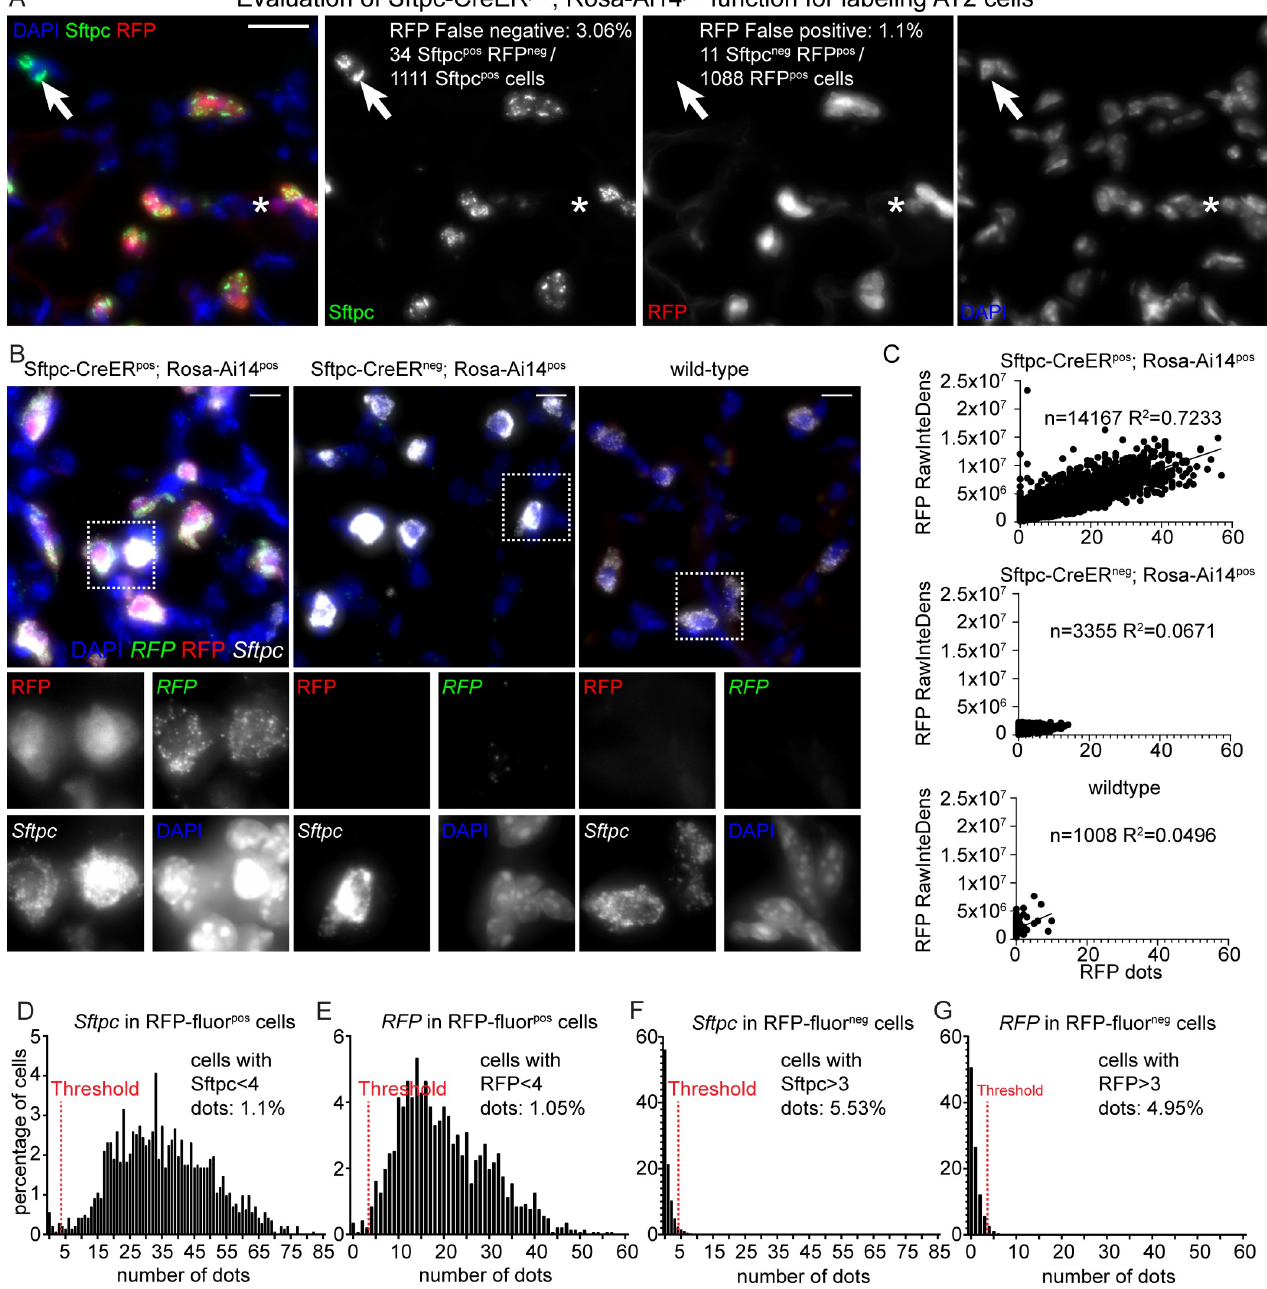
Fig 4. SCRINSHOT efficiently detects RFP and Sftpc mRNAs, upon Sftpc-CreER driven recombination in Sftpc-CreER pos ; Rosa-Ai14 pos lung cells. (A) Evaluation of recombination efficiency, in the SCRINSHOT-analyzed, P21 Sftpc-CreER pos ; Rosa-Ai14 pos lung, after one Tamoxifen induction, on P1. Sftpc protein was detected in AT2 cells with antibody staining and Ai14 (RFP), based on its protein fluorescence. Arrow indicates an Sftpc pos RFP neg AT2 cell and the asterisk, an Sftpc neg RFP pos cell. DAPI: blue, Sftpc-antibody: green, RFP transgene: red. Scale bar: 20 μ m. The data underlying this Figure section can be found in 10.5281/zenodo.3978632. (B) Representative images of alveolar regions from P21 Sftpc-CreER pos ; Rosa-Ai14 pos , P21 Sftpc-CreER neg ; Rosa-Ai14 pos , and P60 wild-type ( Sftpc-CreER neg ; Rosa-Ai14 neg ) lung sections. DAPI: blue, RFP mRNA detected with SCRINSHOT: green, RFP protein fluorescence: red and Sftpc mRNA detected with SCRINSHOT: white. Square brackets indicate the cropped areas of the bottom part of the panel. Scale bar: 10 μ m. (C) Linear regression analyses of RFP protein fluorescence (RAW integrated density) and RFP SCRINSHOT dots, in the 3 analyzed lung sections, using GraphPad Prism. The “n” indicates the number of total cells in the analyzed images and “R 2 ” shows the correlation coefficients. (D-G) Histograms of SCRINSHOT results for Sftpc and RFP in RFP protein fluorescence positive and negative cells. The y-axis shows the percentage of positive cells and x-axis the bins of the detected RNA transcripts number per cell. Threshold was set to 3 dots and shown with red dotted lines. Percentages in “D” and “E” correspond to the cells below threshold